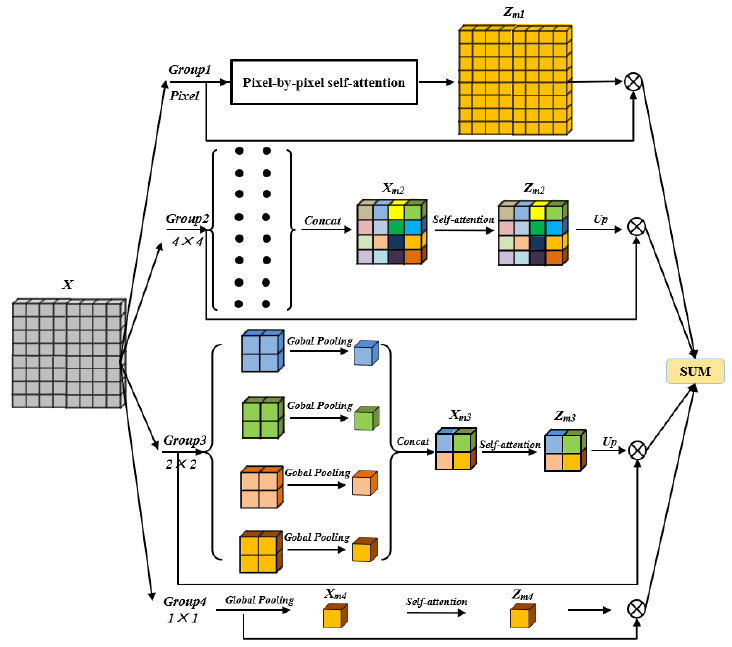
Figure 3. Proposed RePyAtt Module. We first generate a region pyramid by partitioning the input feature maps (left) into four groups and employing the self-attention mechanism to extract the regional dependence. Finally, the output of the RePyAtt module is obtained by summation (‘SUM’) of different region